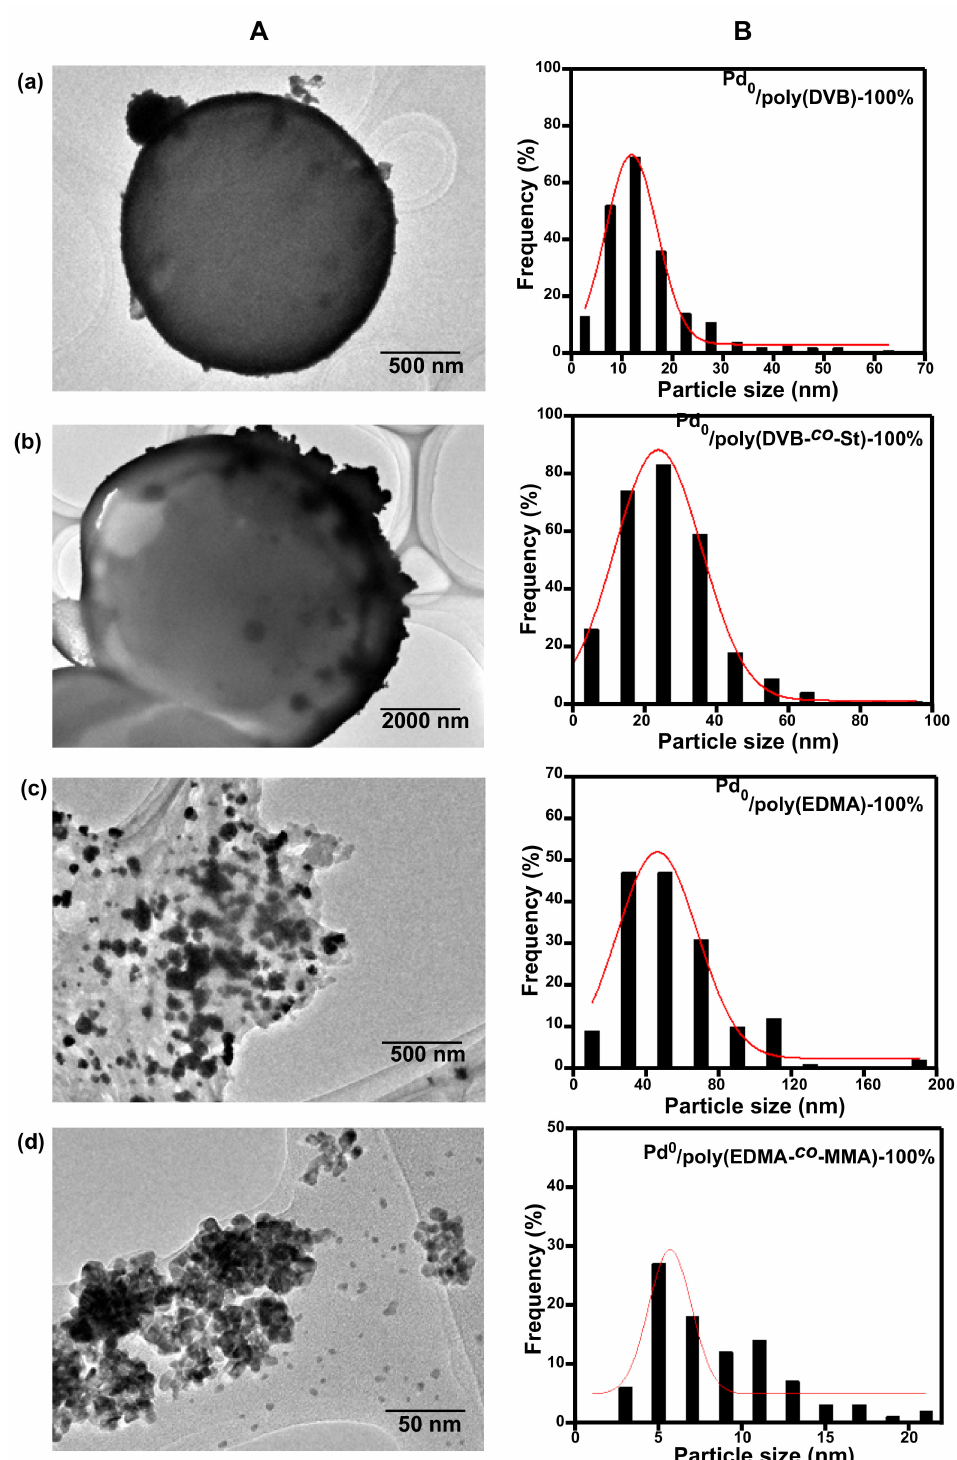
Figure 2. ( A ) TEM images and ( B ) particle size distributions of ( a ) Pd 0 /poly(DVB)-100%; ( b ) Pd 0 /poly (DVB-co-St)-100%; ( c ) Pd 0 /poly(EDMA)-100%; ( d ) Pd 0